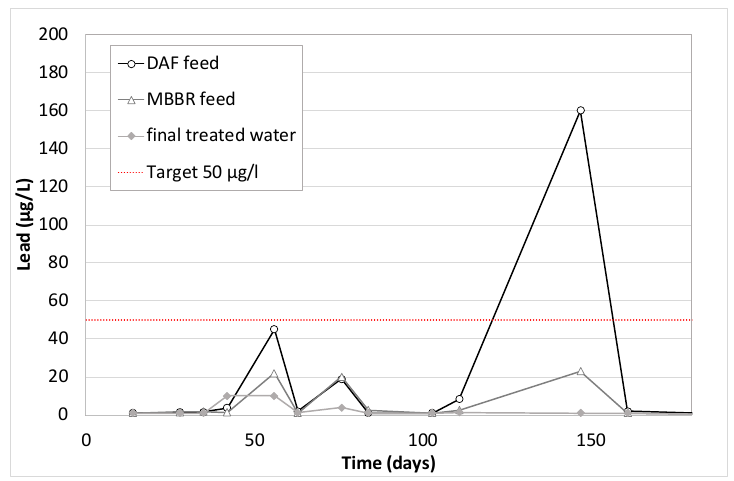
Figure 16. Zinc concentration along the pilot unit versus time of operation.